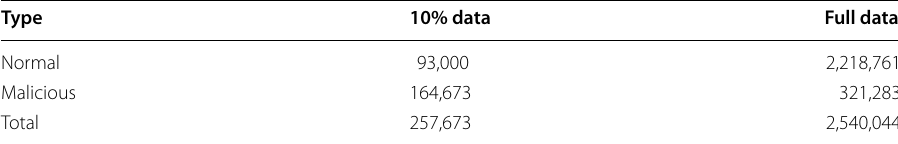
Table 1 UNSW-NB15 data-set records